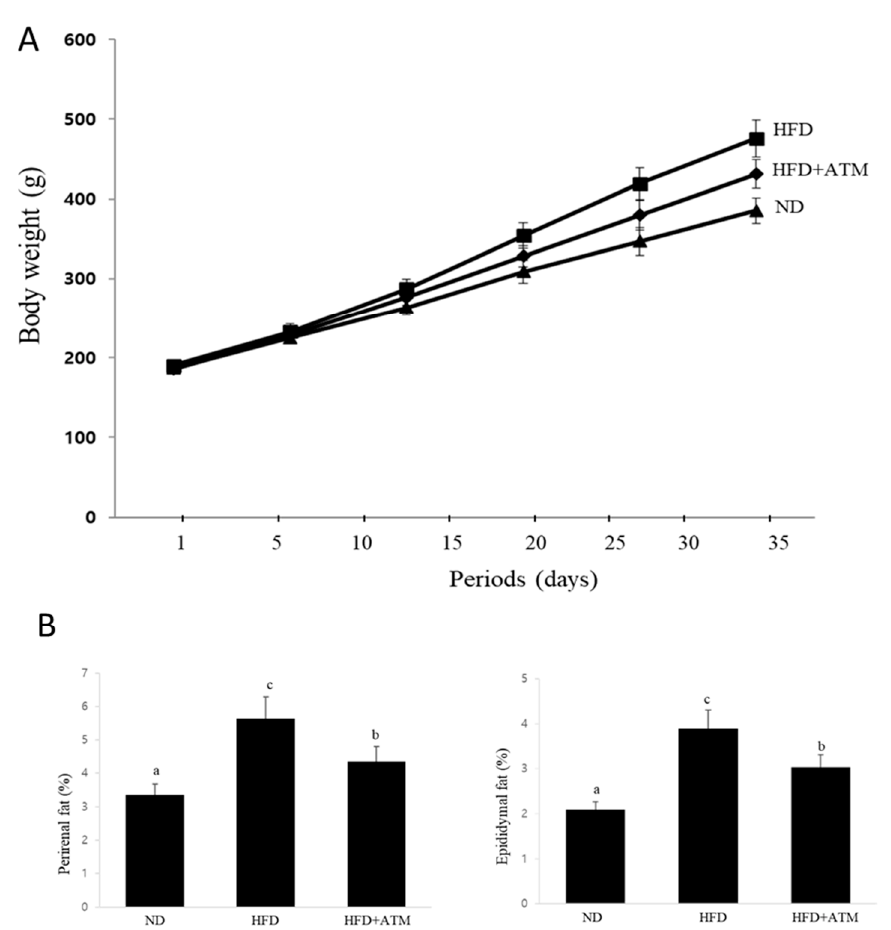
Figure 4. Effects of ATM on adiposity in HFD-induced obese rats. Rats (n = 10) were fed a normal diet or high-fat diet (HFD) for five weeks in the presence (150 mg/kg/day) or absence of ATM. ( A ) Effect of ATM on body weight in HFD-induced obesity in rats. The control group was fed a normal diet (ND), HFD + ATM groups were fed an HFD plus ATM (150 mg/kg body weight (BW)), and HFD groups were fed a high-fat diet (diet with 60% kcal fat). The BWs of each of the animals were measured twice a week. BWs at the end of the experiment were significantly different between the HFD and ND ( p < 0.01) and HFD + ATM groups ( p < 0.05). ( B ) Effects of ATM on perirenal and epididymal fat weights. The weights of perirenal and epididymal adipose tissue were measured by dividing fat tissue weight by body weight (fat tissue/body weight × 100%). The values are presented as means ± SD. Bars with di ff erent letters are significantly di ff erent ( p < 0.05), as determined by Duncan’s multiple range